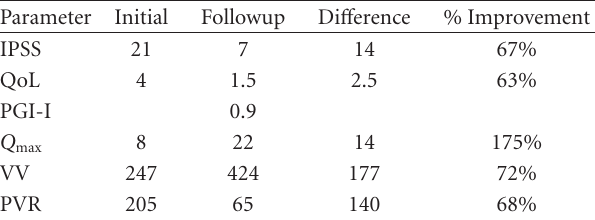
Table 3: Overall long-term outcome results post-TURP.